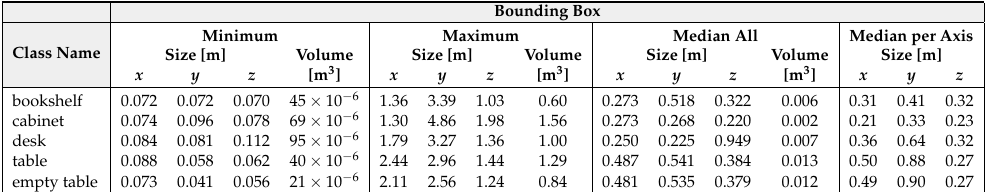
Table 2. Minimum, maximum, and median volume of annotated storage space with corresponding size in each direction for each furniture class in the synthetic dataset. Column “median per axis” shows the median length, height, and width of each furniture class.